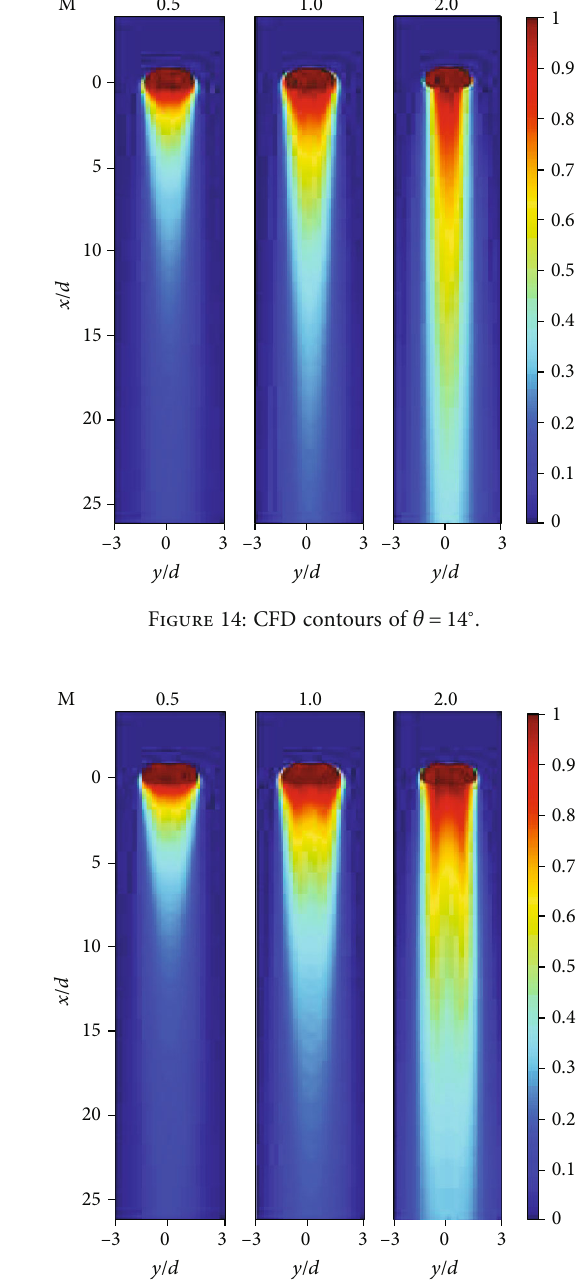
Figure 15: CFD contours of θ = 17 : 5 ° .